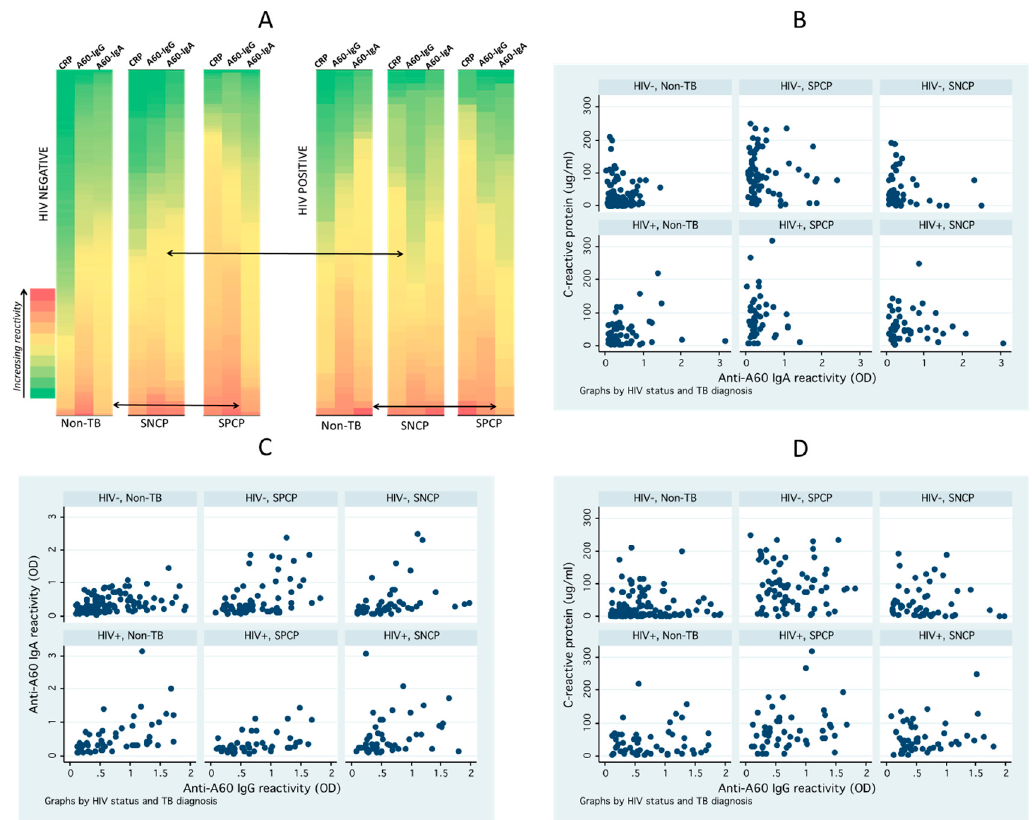
Figure 2. Biomarker reactivity and correlation by diagnostic group and HIV status. ( A ) Heat map of biomarker reactivity illustrates high degree of heterogeneity across patients and difference in reactivity between HIV − ve and HIV+ve patients. Individual patients are colored green to red according to increasing relative reactivity/concentration for biomarker (CRP, anti ‐ A60 IgG, anti ‐ A60 IgA). ( B – D ) Scatterplots of biomarkers shows slight but significant correlation of anti ‐ A60 antibodies, and lack of correlation between anti ‐ A60 antibodies and CRP.